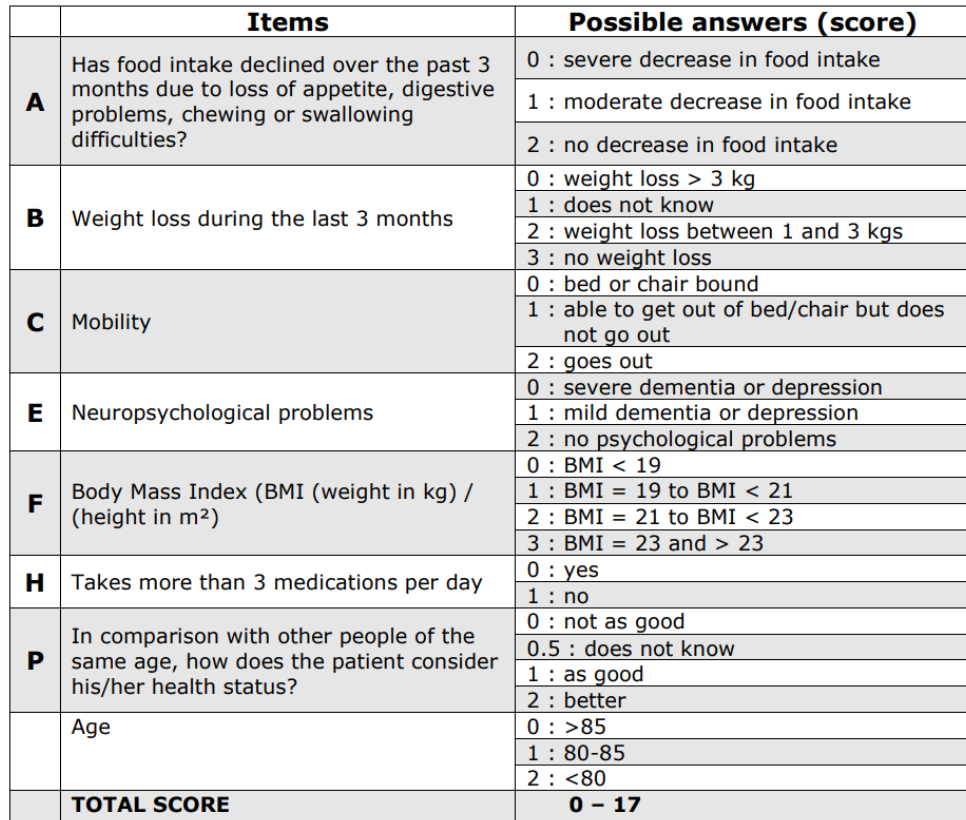
Figure A1. G8 questionnaire.